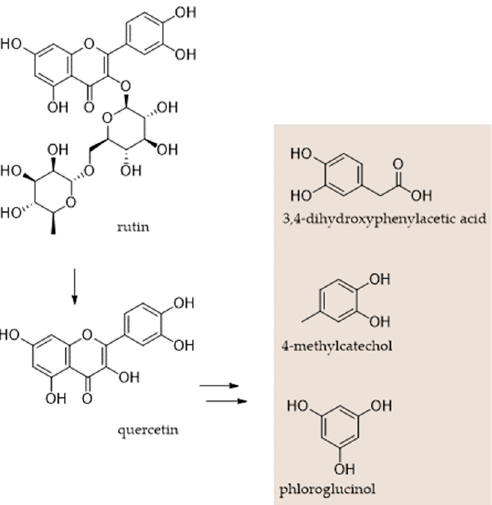
Figure 5. Quercetin, and its rutinoside (rutin), as well as the metabolite 3,4-dihydroxyphenylacetic acid, 4-methylcatechol, and phloroglucinol. Berger et al. [70] showed that when incubated in vitro with rumen, quercetin disappeared, and 3,4-dihydroxyphenylacetic acid rapidly increased, followed by 4-methylcatechol. Both quercetin and rutin did not affect in vitro methanogenesis.